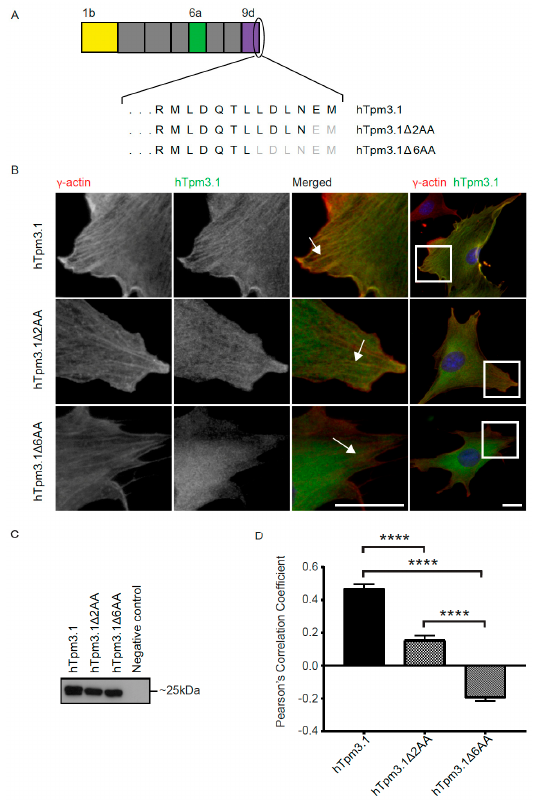
Figure 3. Expression of C-terminal deletion plasmids in NIH3T3 cells. NIH3T3 cells were